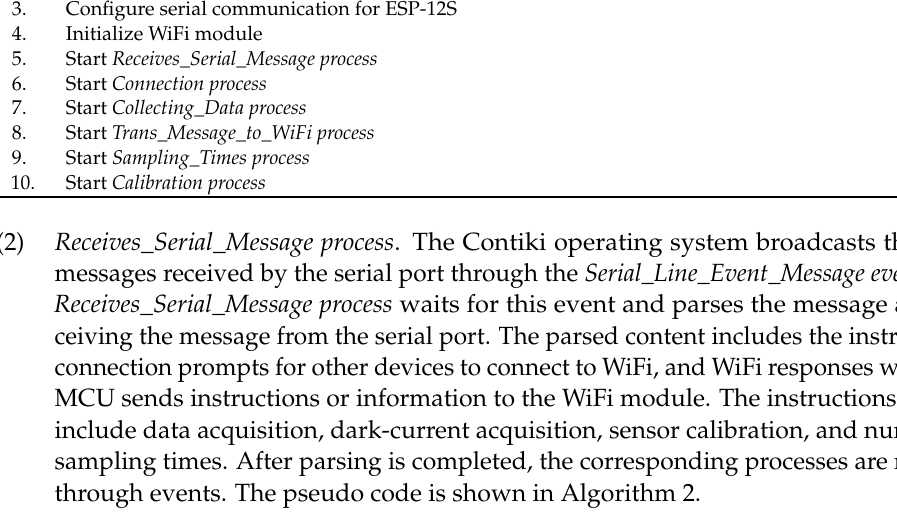
Algorithm 1: The pseudo code of the Initialization process